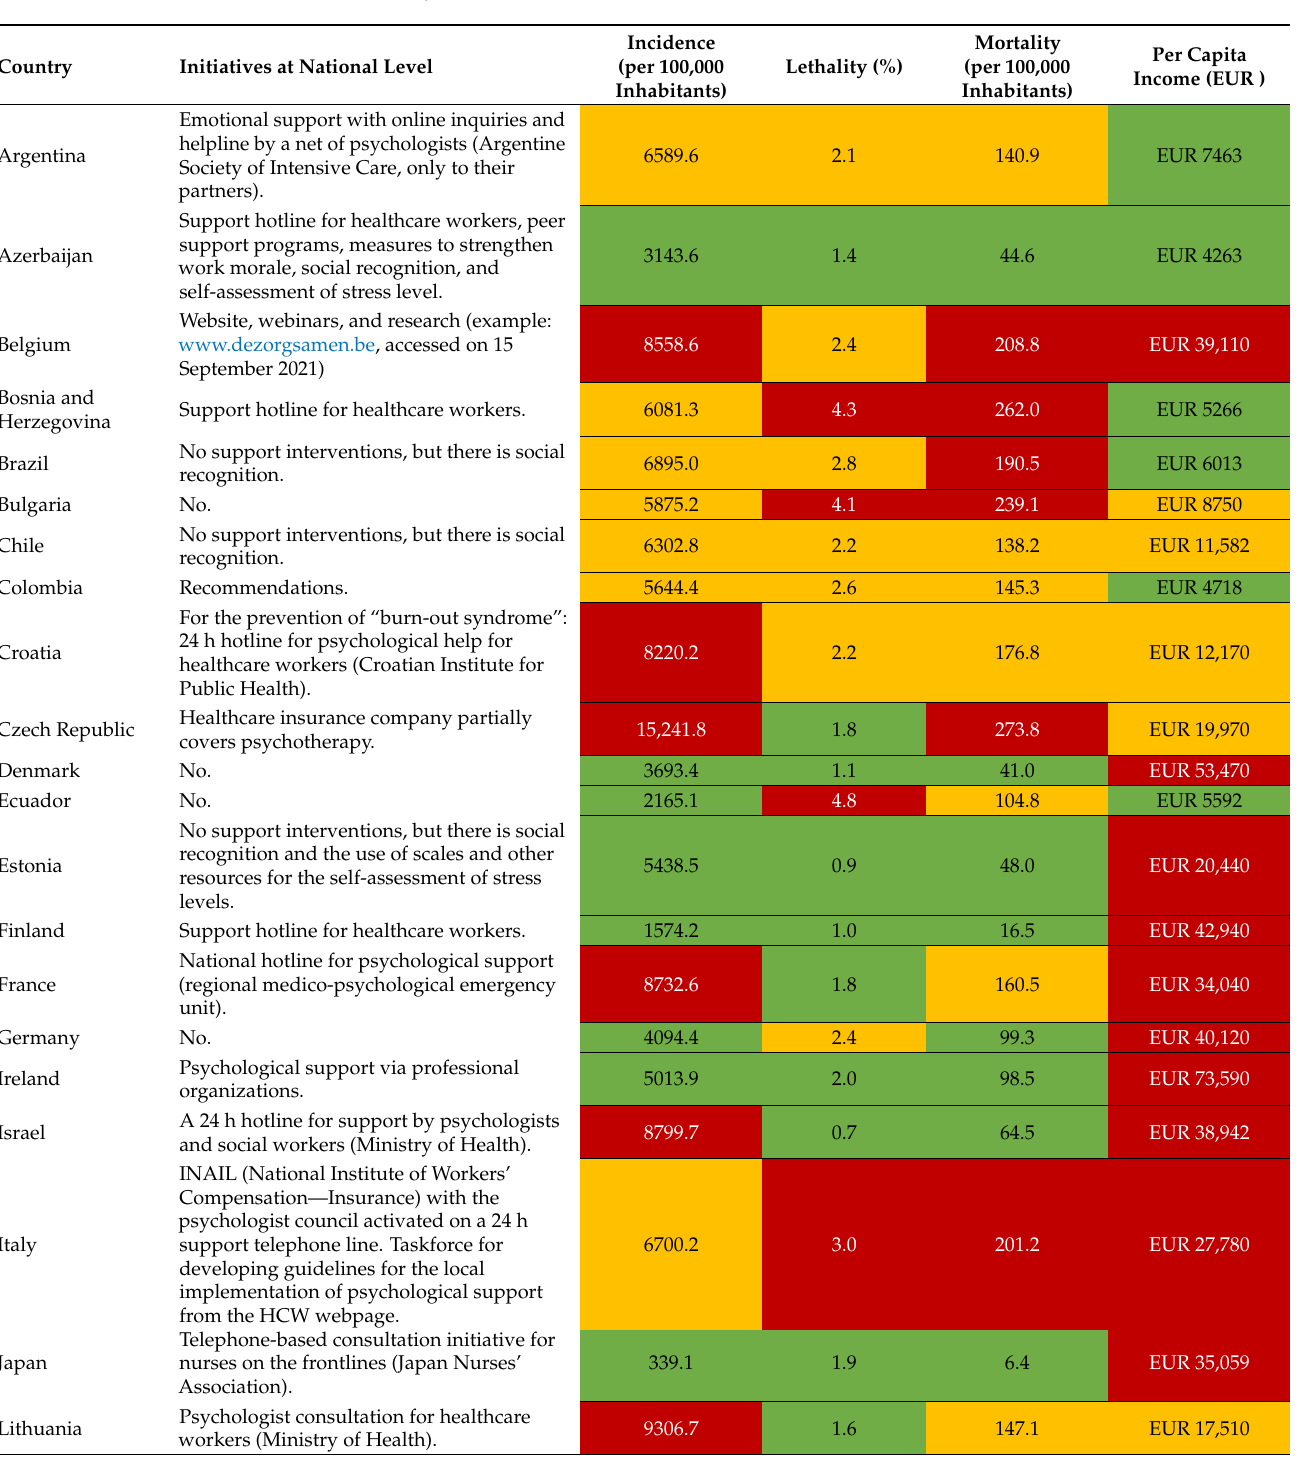
Table 3. Initiatives to provide emotional and psychological support to healthcare professionals at the national level and reduce their stress levels, and the incidence, lethality (or case fatality), mortality rates due to COVID-19 (data updated as of 5 March 2021) and the per capita incomes (2020) of each